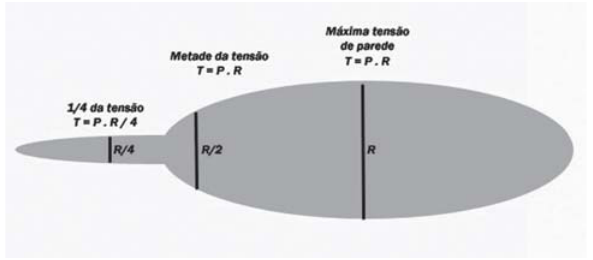
Fig. 7 - Balão que exemplifica a Lei de Laplace. O princípio de Pascal diz que a pressão é a mesma em todos os pontos do balão, mas há grande diferença nas tensões de parede em diferentes partes do balão. Essas variações são descritas pela Lei de Laplace. T=tensão de parede, P=pressão, R=raio do